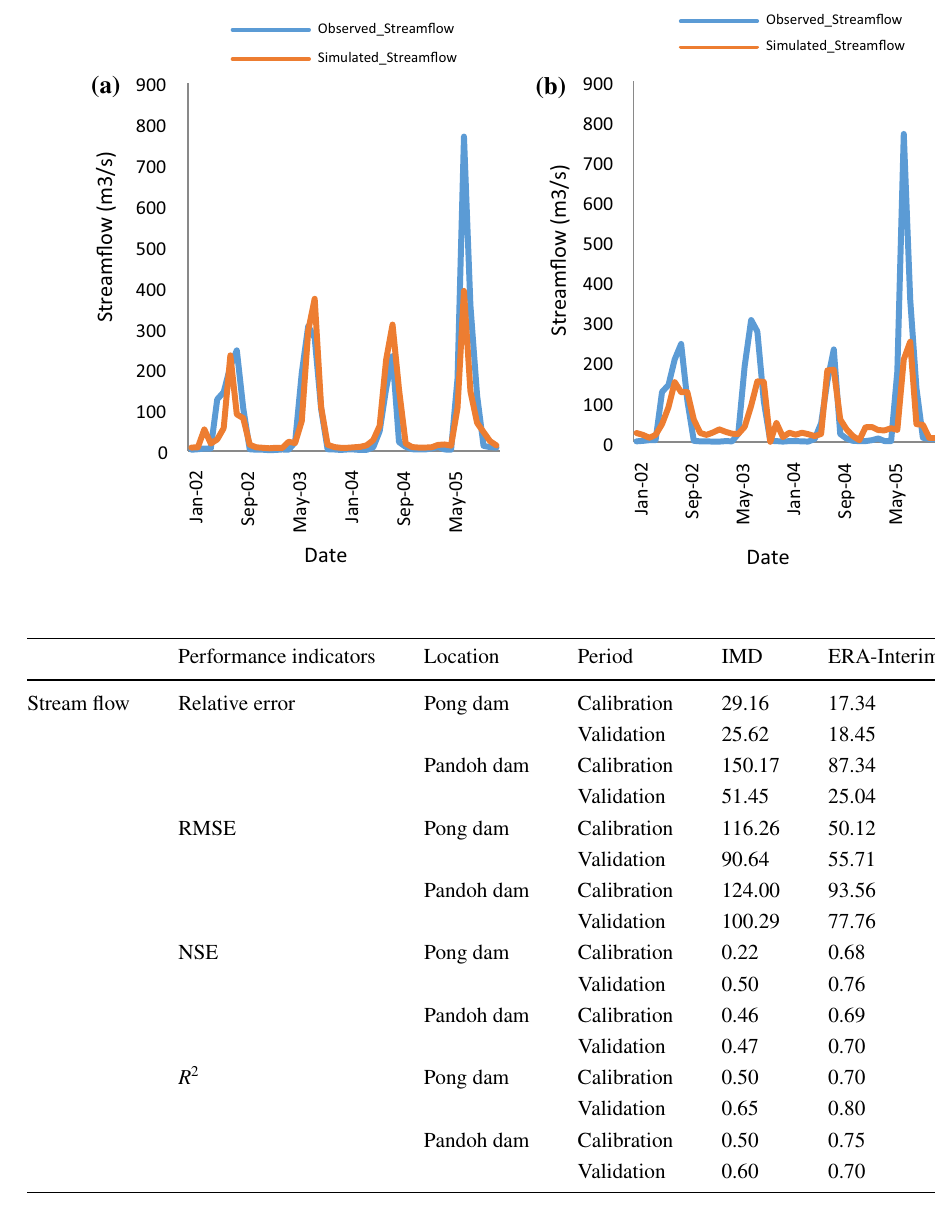
Fig. 14 Hydrograph of the observed and calibrated monthly flow for the calibra- tion period of Pandoh dam for a ERA-Interim and b IMD weather data